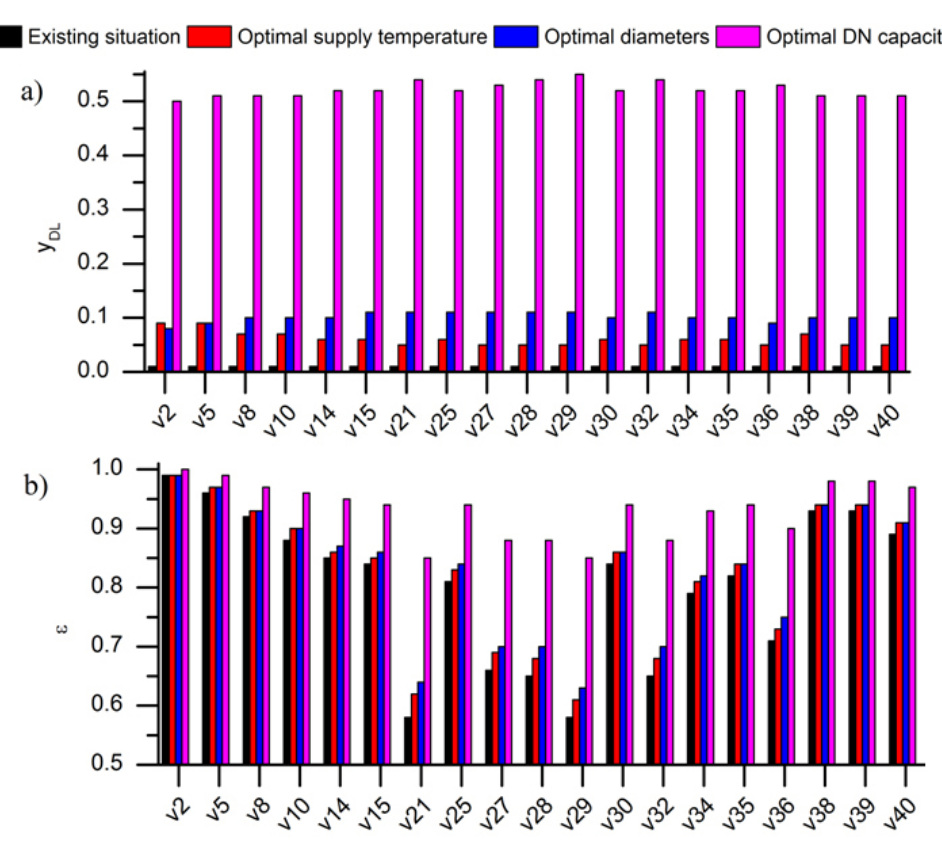
Figure 5. Results: ( a ) Exergy destruction to loss ratio; ( b ) Exergetic